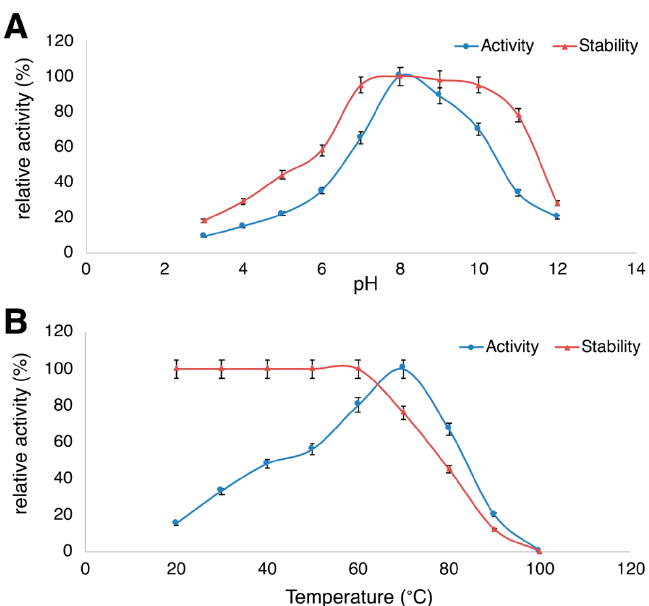
Figure 3. Effect of pH ( A ) and temperature ( B ) on B. megaterium -TK1-derived protease activity and stability. Values shown in ( A ) and ( B ) (mean ± standard deviation (SD)) are representative data obtained in triplicate tests from two independently performed experiments using purified B. megaterium -TK1-derived